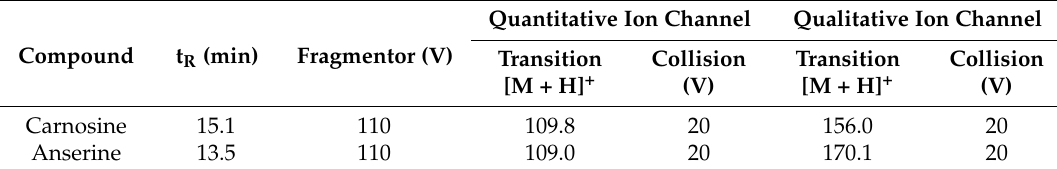
Table 1. Retention time (t R ), MRM transitions, optimized fragmentor and collision voltages of carnosine and anserine.